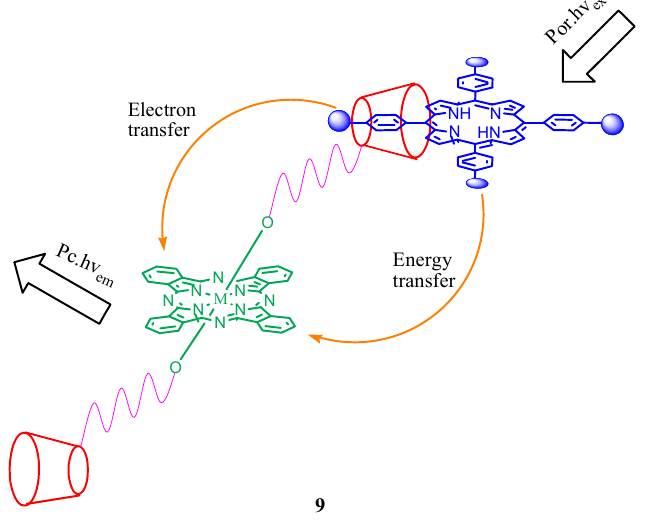
Figure 9. Energy- and electron-transfer between the porphyrin and pthalocyanine connected through a β -cyclodextrin spacer ( 9 ).